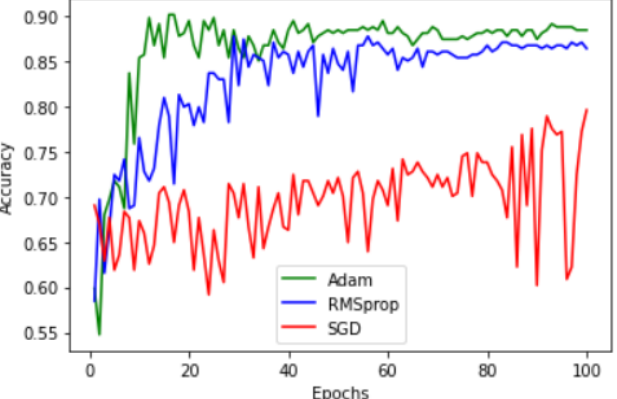
Figure 10. ROC score for CNN+BiGRU.